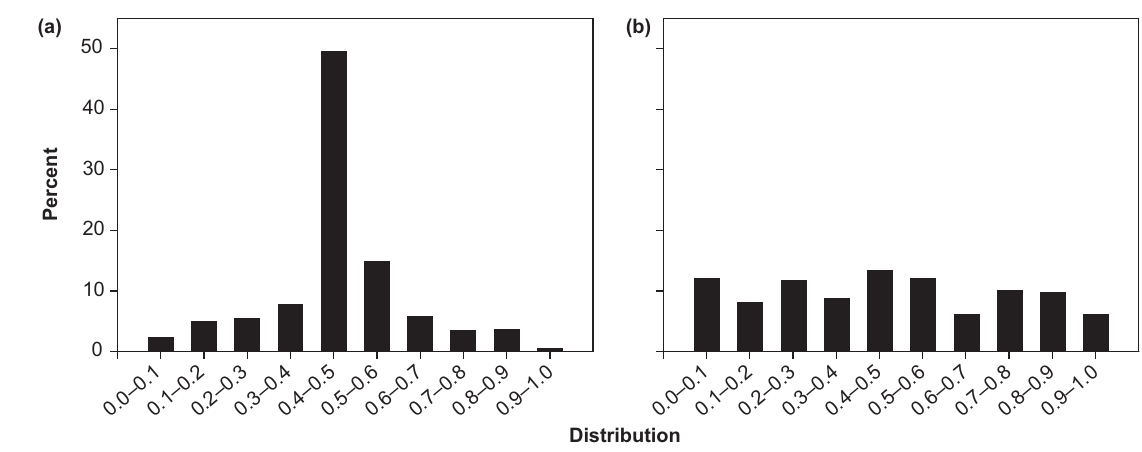
Figure 1. Distributions of the mid-ratios (middle – low)/(high – low) for colony triples. (a) RTS, 1343 triples, 128 experiments; (b) other investigators, 572 triples, 59